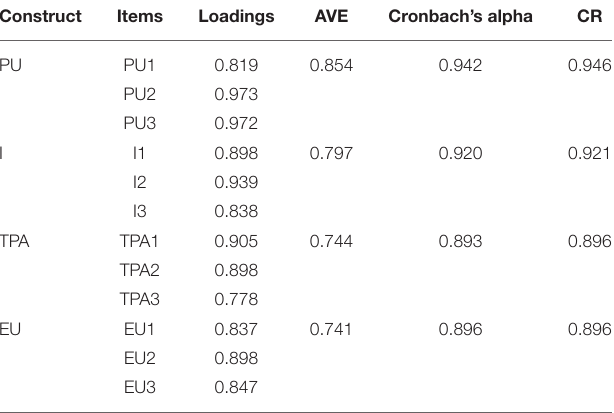
TABLE 2 | Factor loadings and reliability indices. Construct